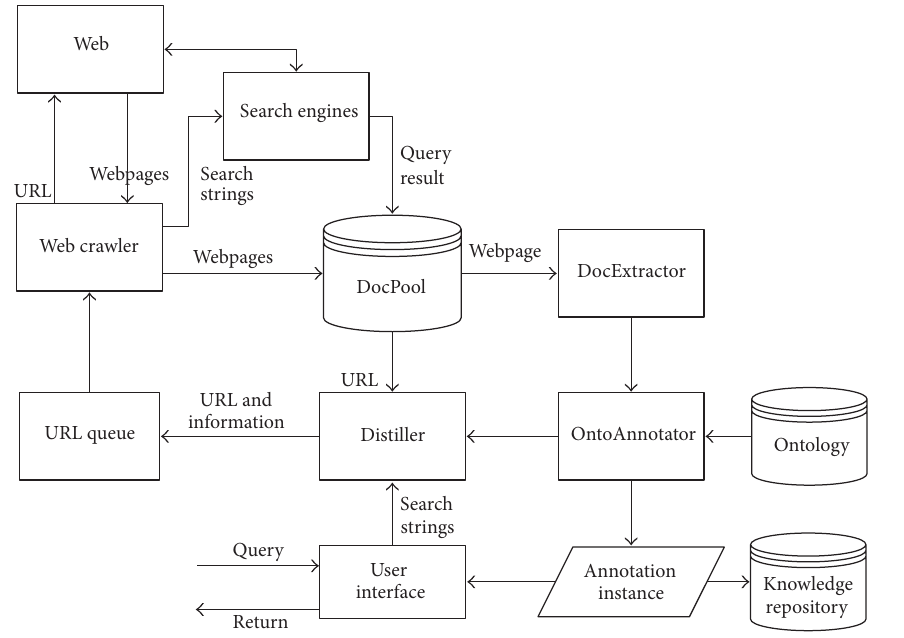
Figure 5: The network focused crawler